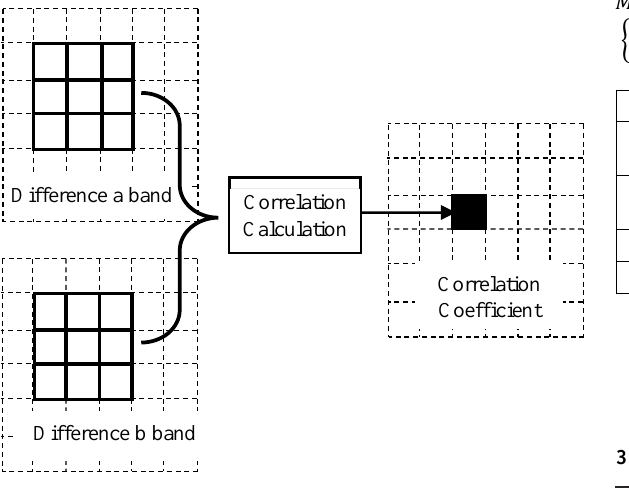
Figure 2. Spatial correlation calculation between two images